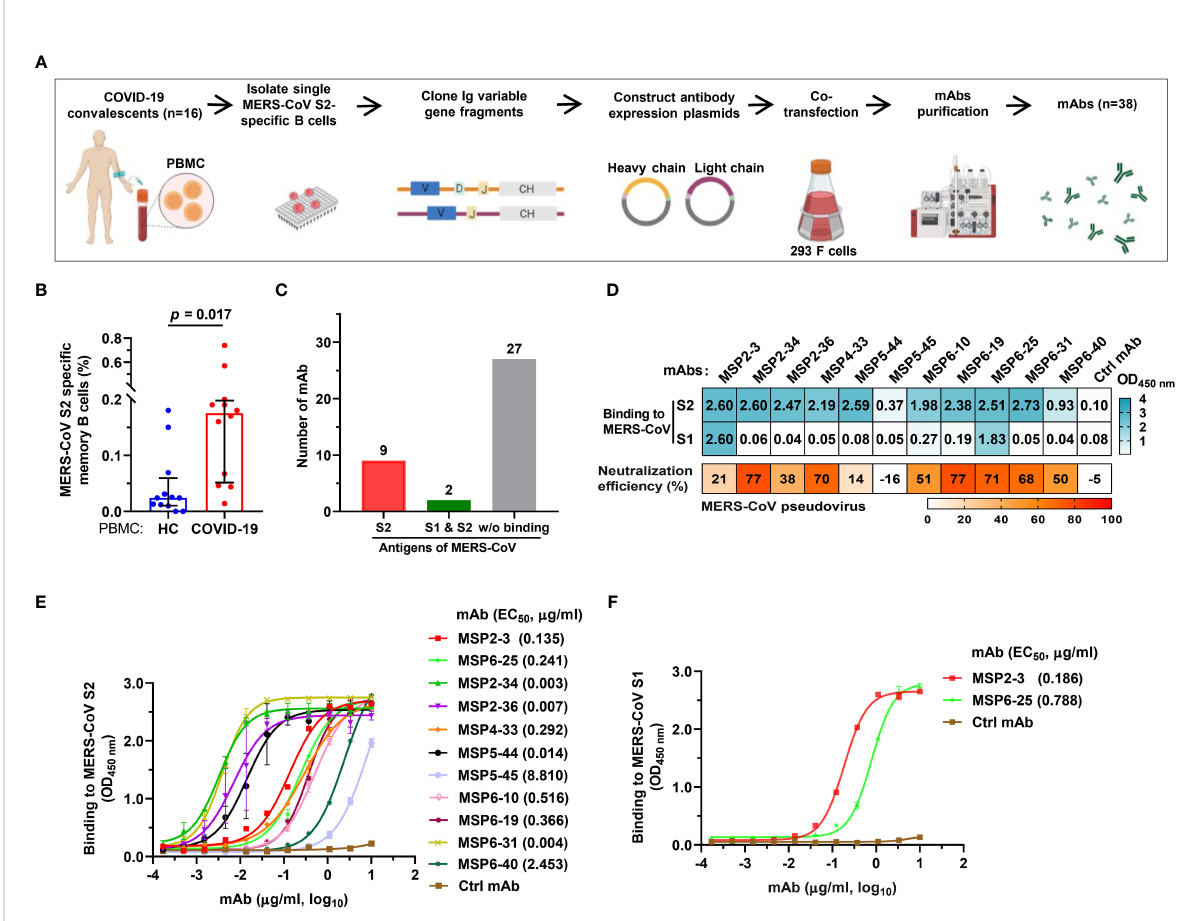
FIGURE 2 Isolation of MERS-CoV S2-speci fi c antibodies from COVID-19 convalescent memory B cells. (A) The work fl ow of producing human monoclonal antibodies (mAbs) by cloning antibody genes from memory B cells. The memory B cells were isolated from PBMCs of 16 COVID-19 convalescents, and the variable regions of the heavy and light chains of antibodies (VH, VL/VK) were ampli fi ed from single B cells by RT-PCR and cloned into antibody expression vector plasmids. The selected VH and VL/VK clones were sequenced and co-transfected into 293F cells. The supernatants were taken after 6-7 days of culture, and the monoclonal antibodies were puri fi ed by ÄKTA Puri fi er. (B) The frequency of MERS-CoV spike S2-speci fi c memory B cells in healthy blood donors and COVID-19 convalescents. Twelve experiments of cell screening were performed, and one healthy sample (negative control) was included in each experiment. Unpaired t -test was used to compare the difference between two groups, p <0.05 was considered for statistical signi fi cance (GraphPad Prism, version 8.0). (C) mAbs binding to MERS-CoV S1 and/or S2. A total of 38 mAbs constructed in this study were tested. (D) The binding of mAbs (1 m g/ml) to MERS-CoV S1 or S2 (cyan). The OD 450nm >0.3 was de fi ned as positive. Neutralization of mAbs (50 m g/ml) against MERS-COV pseudovirus was de fi ned as >50% infection reduction. (E, F) ELISA curves of antibodies binding to MERS-CoV S1 and S2. An unrelated anti-HCV mAb, 2HCV5, was used as negative control (Ctrl mAb). Error bars indicate the mean ± standard error of mean (SEM), and the data represent technical replicates of at least two independent experiments. Data were analyzed and plotted by GraphPad Prism (version